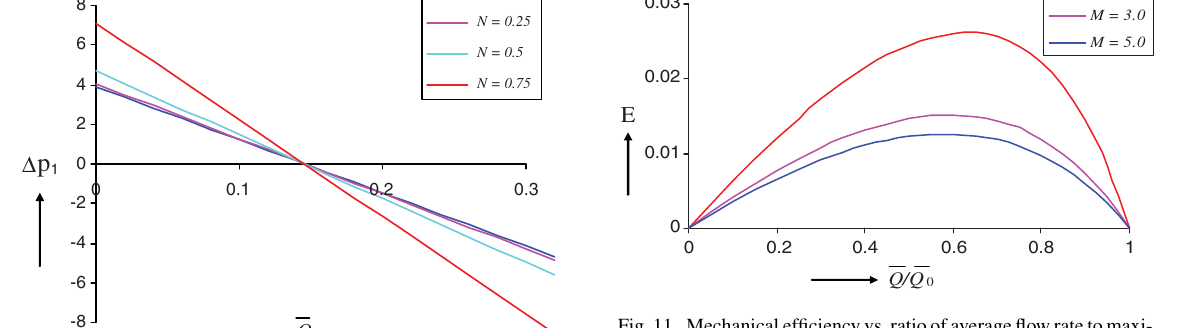
Fig.11. Mechanicalefficiencyvs.ratioofaverageflowratetomaxi- mumaverageflowrate,basedonEq.(33),curvesrepresentefficiency of peristaltic pump for M =1.0, 3.0, 5.0, φ =0.4 and N =0.50.